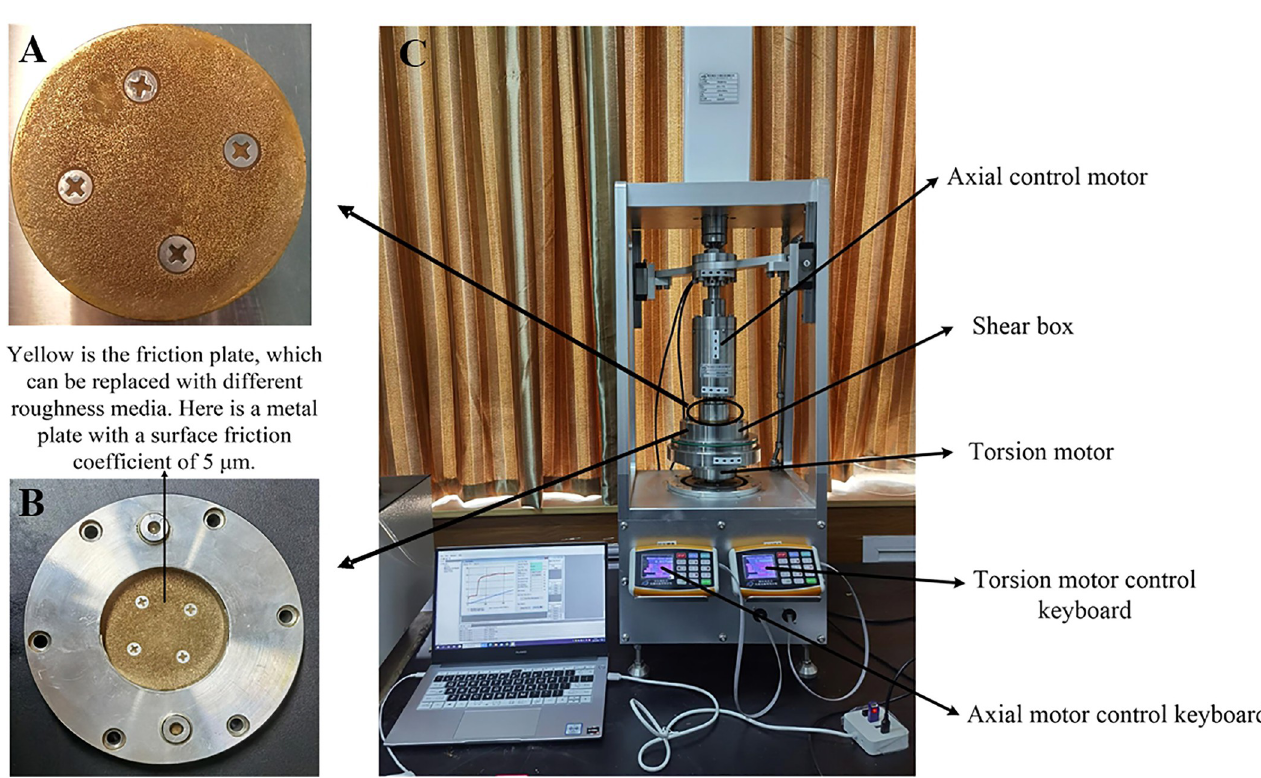
Fig 3. Interface shear test instrument & shear box. (A) Shear head. (B) Shear box. (C) Interface shear test instrument.